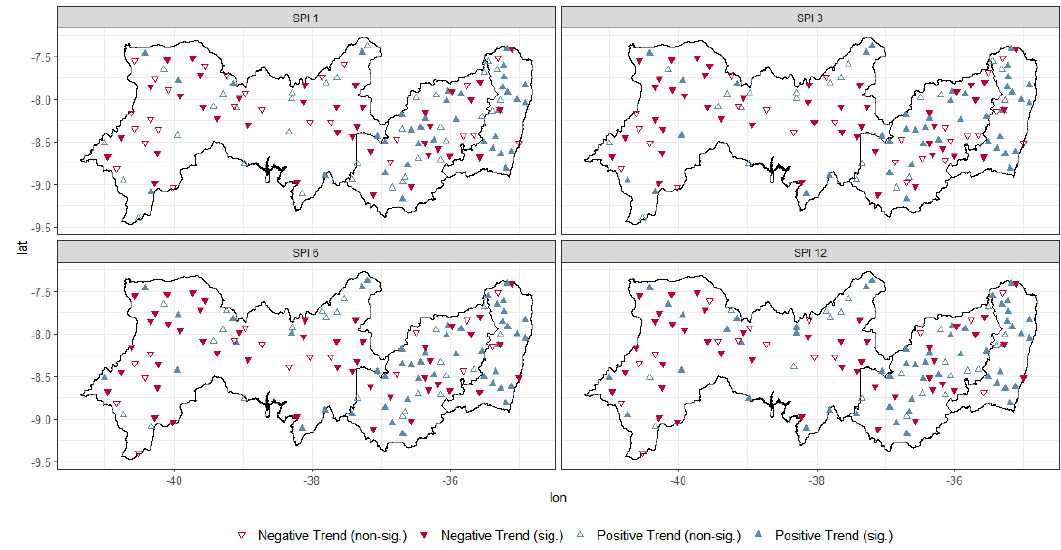
Figure 5. Spatial distribution of the SPI trend over Pernambuco state, at a significance level of 0.05. Filled triangles indicate significant trends, as obtained by Mann–Kendall test.